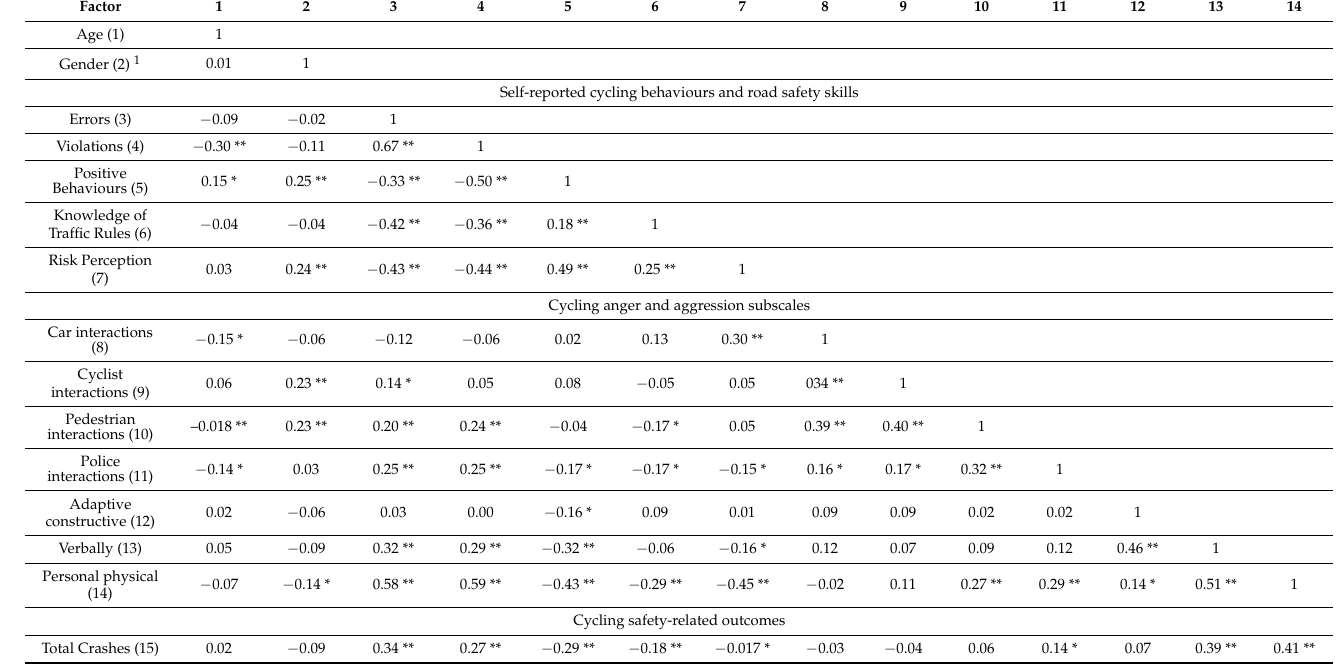
Table 5. Bivariate (Pearson)